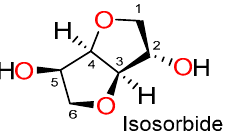
Figure 2. The biobased carbon content of these monomers is about 18%.